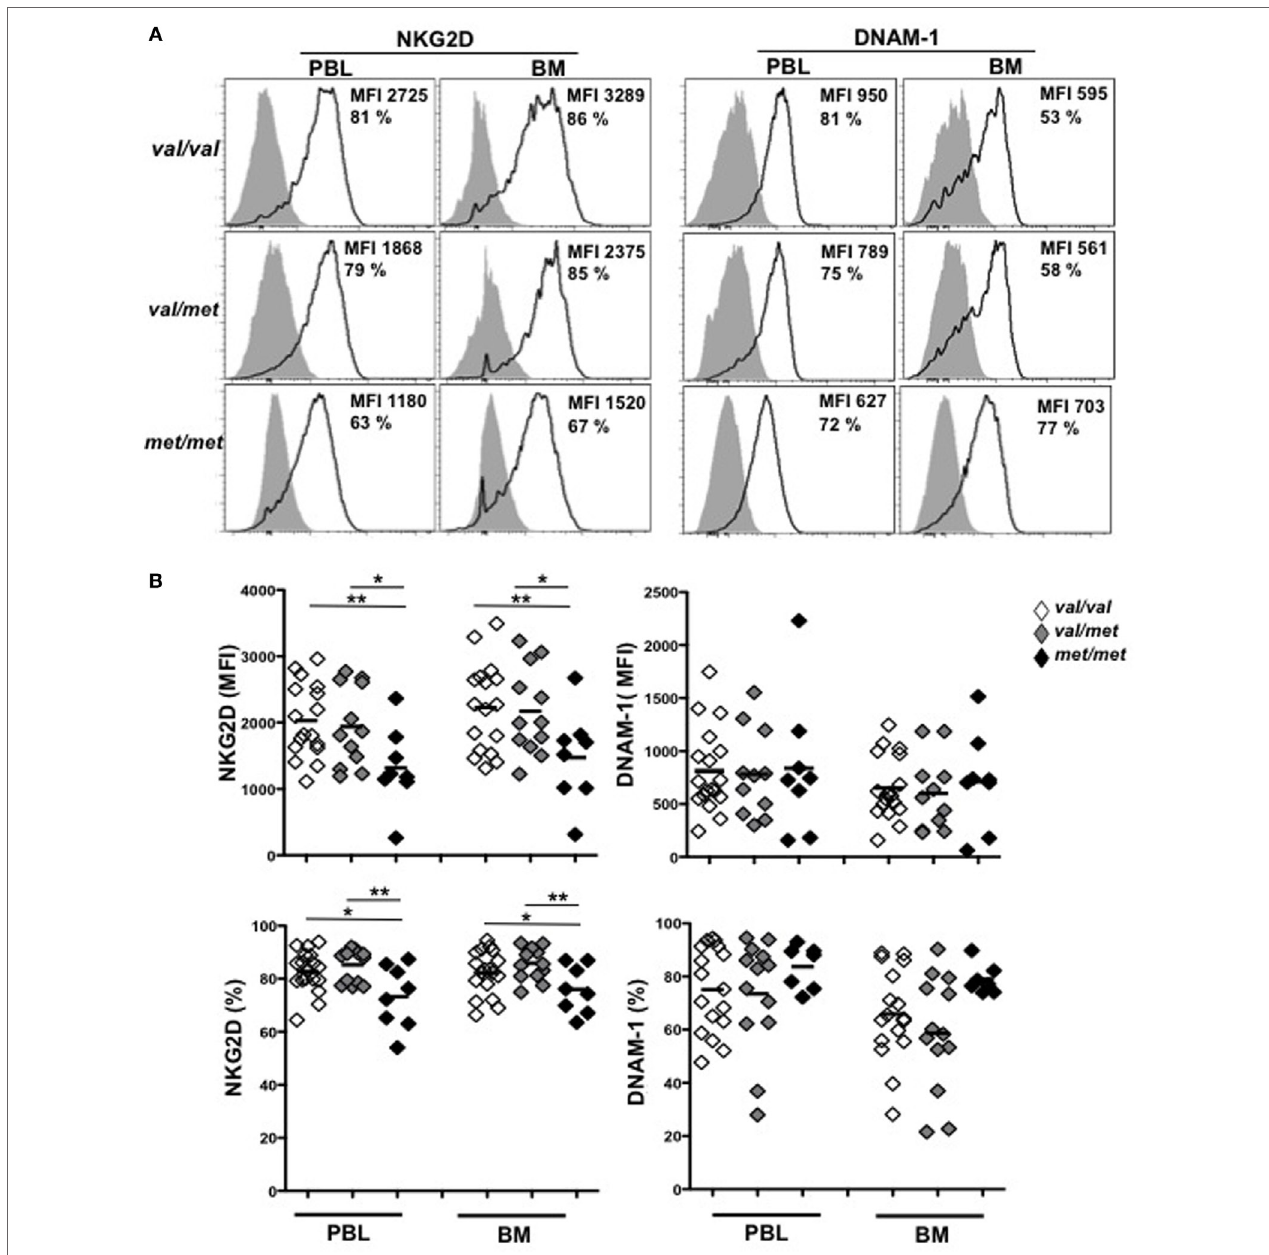
FigUre 4 | MICA-129Met allele is associated with an increased NKG2D downmodulation on natural killer (NK) cells gated from patients. Total cells derived from the bone marrow (BM) or the peripheral blood (PBL) derived from patients at different disease states (including smoldering, onset, and relapse) were stained with antibodies against CD45, CD138, CD56, and CD3. NKG2D or DNAM-1 expression was evaluated by gating on NK cells (CD45 + CD138 − CD3 − CD56 + ). (a) Representative histograms are shown. (B) Values reported represent the MFI values of NKG2D or DNAM-1 subtracted from the MFI value of the isotypic cIg or the percentage of NKG2D and DNAM-1. Total number of patients analyzed, n = 40 (Val/Val = 19, Val/Met n = 13, Met/Met = 8). Abbreviations: Val, valine; Met,